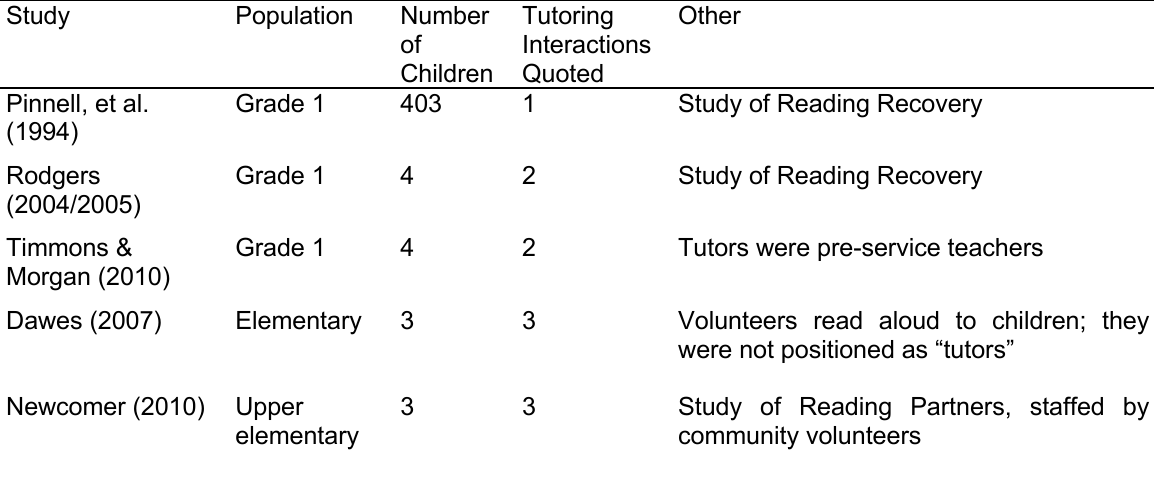
Characteristics of Tutoring Studies that Include Excerpts of Discourse About Student Difficulty